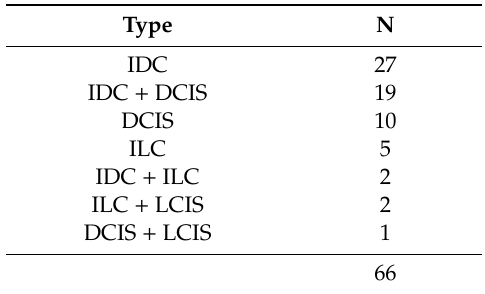
Table 2. Malignant lesions detected by